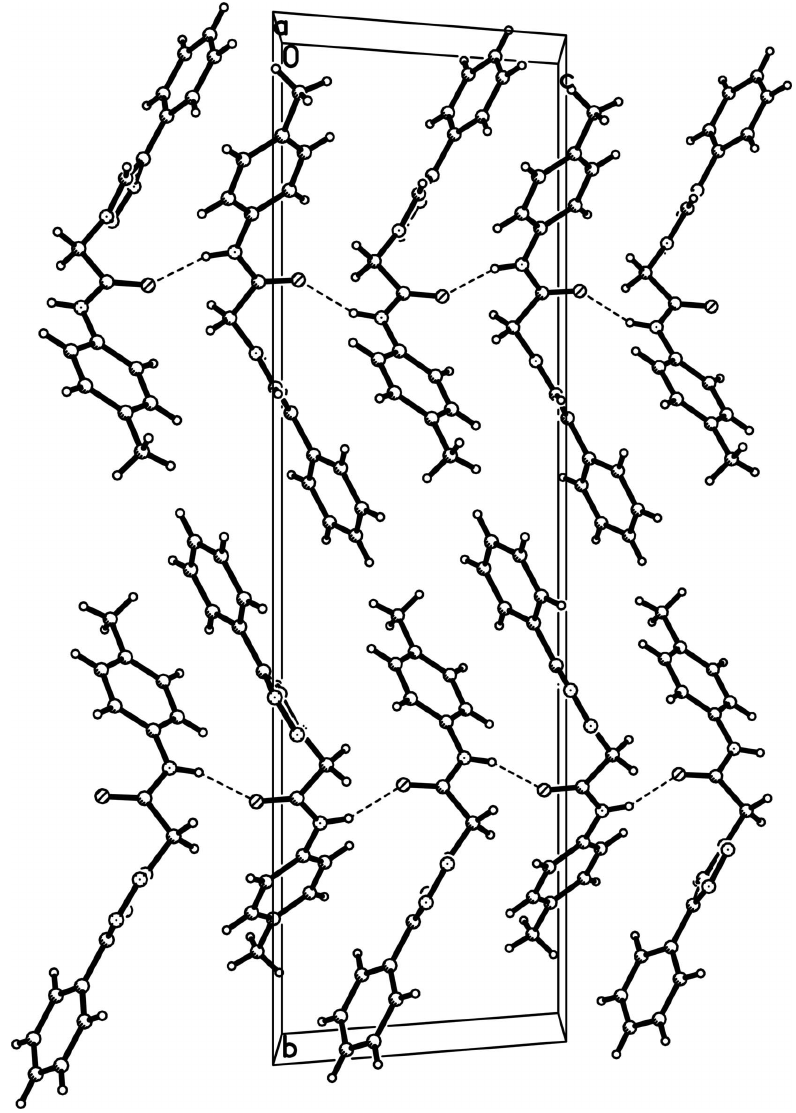
Figure 2 A packing diagram of (I), viewed down the a axis. Dashed lines denote N—H···O hydrogen